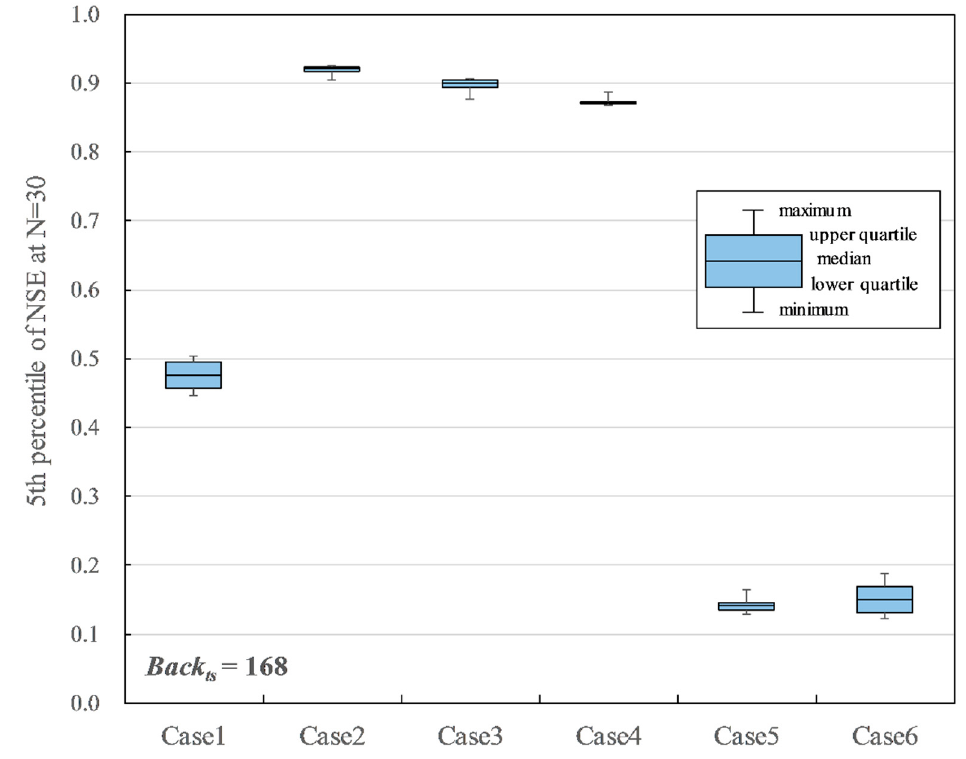
Figure 10. Summarized training results for Case 1 to Case 6 when Back ts = 168, Drp = 0, Drp r = 0.